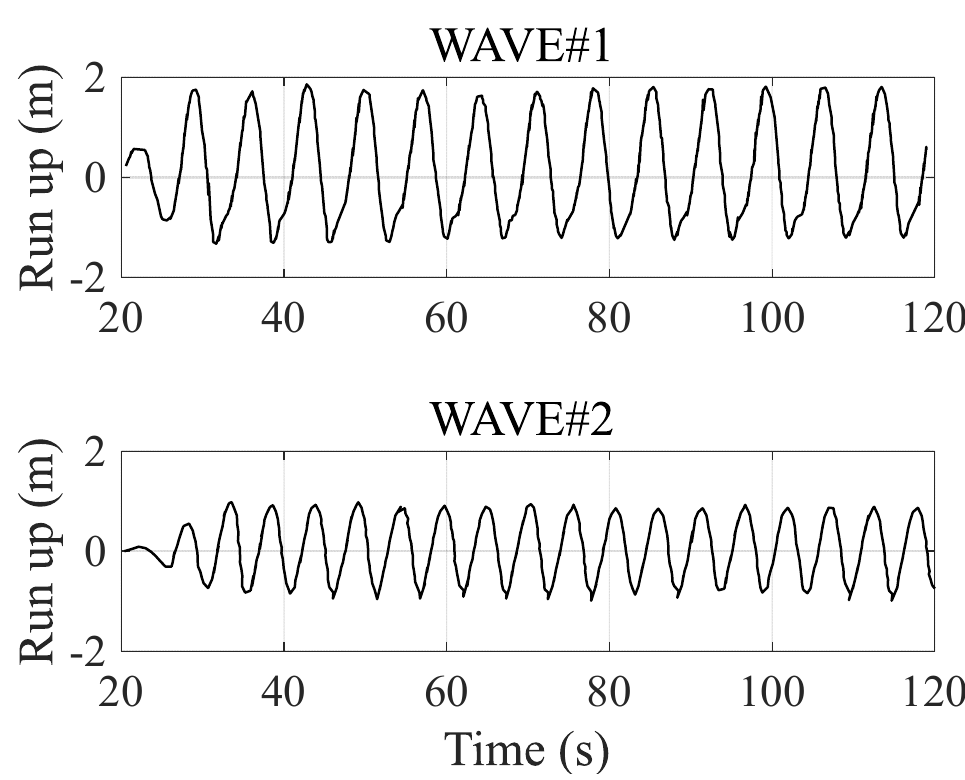
Figure 9. Wave run-up time series of irregular Wave#1 and Wave#2 .